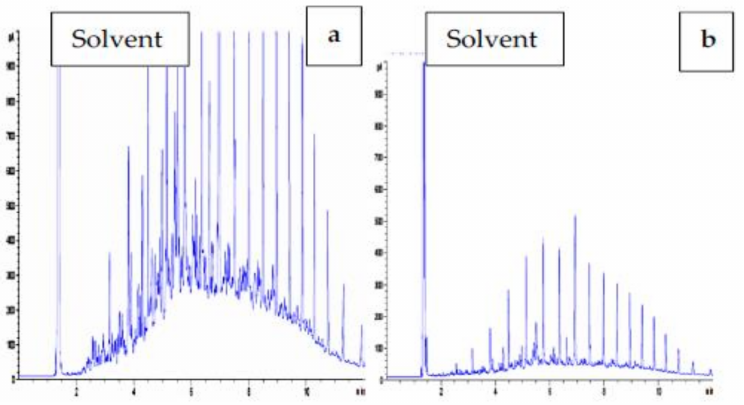
Figure 11. Comparative chromatograph of ( a ) contaminated non-rhizosphere (CN) and ( b ) contami- nated rhizosphere (5% oily sludge with C. cajan ) after 90